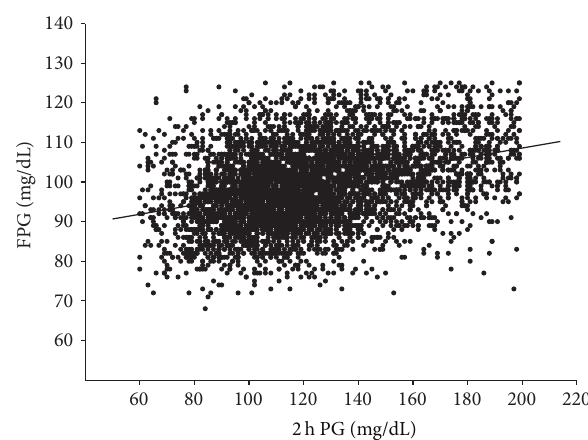
Figure 1: Simple linear regression line between 2 h PG and FPG levels based on least square method is indicated by solid line ( 𝑦 = 0.119𝑥+84.70 ). There was a positive correlation between 2 h PG and FPG significantly ( 𝑟 = 0.355 , 𝑝 < 0.0001